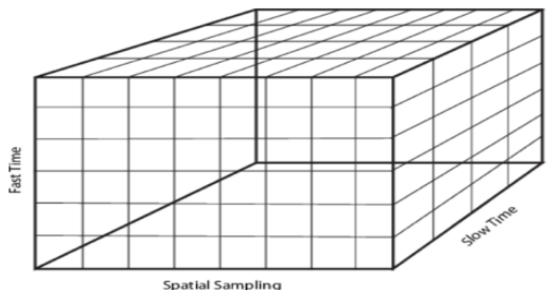
Fig. 3. Virtual array with 2 transmitters and 4 re c eivers [28]